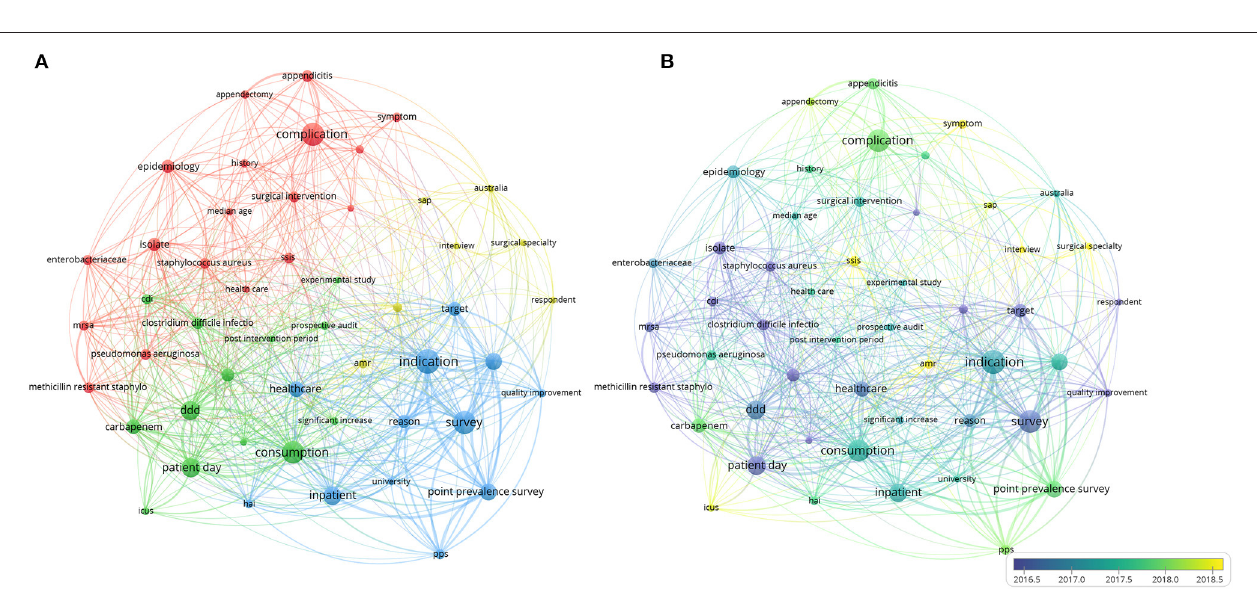
FIGURE 7 | Bibliometric analysis of themes. (A) Distribution map of the themes. Four clusters in green, bule, red and yellow were shown in the map, the nodes with same color represented a similar topic according to titles and abstracts. (B) Network map of the trend topics. The current publications in different color from purple to yellow. The size of the nodes demonstrates the frequency of appearance as the keywords and the distance between the two circles indicates their correlation.